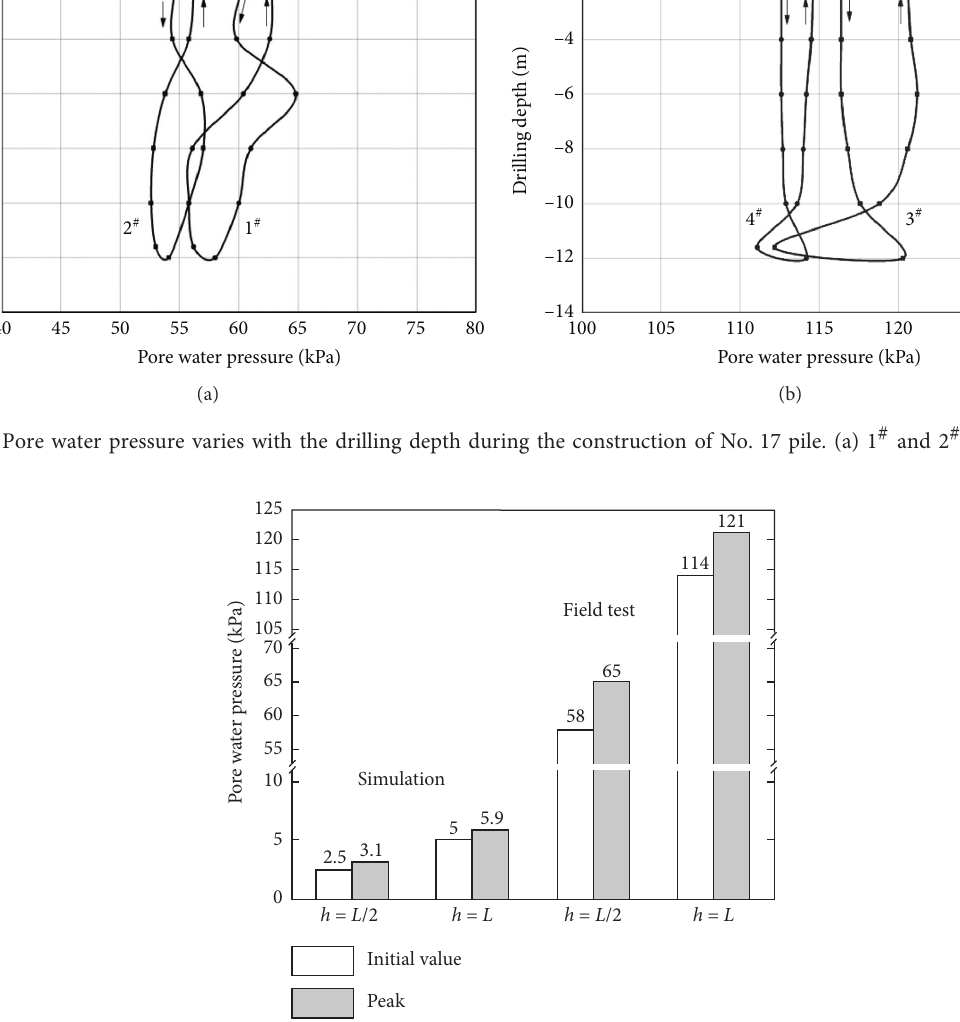
u versus radial distance.